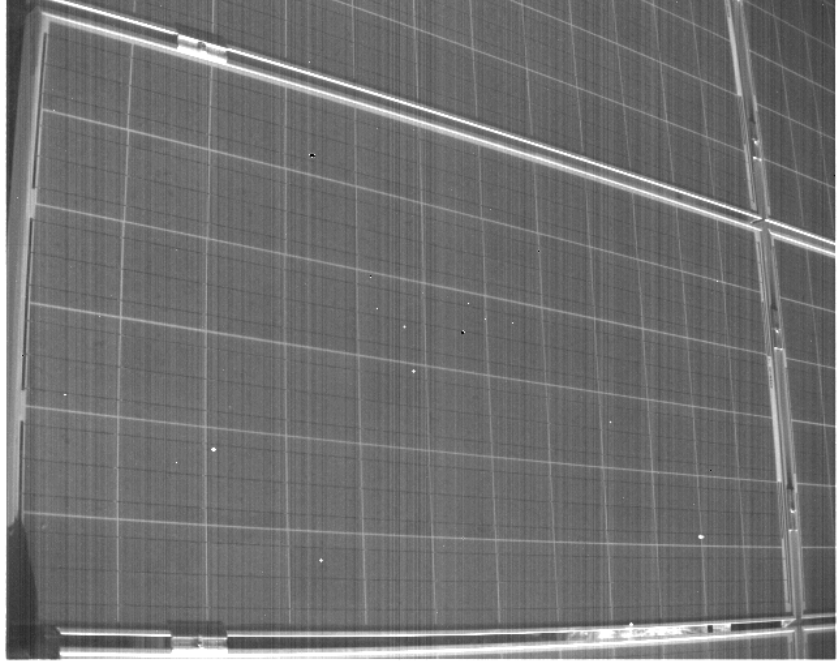
Figure A2. Original DaySy ™ photography image of Solarzentrum Stuttgart GmbH affected by barrel lens distortion. Straight line structures in the PV module are represented by curved line structures in the